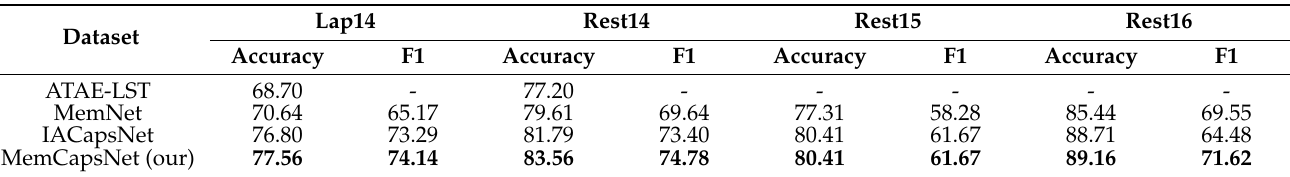
Table 4. The metrics of accuracy and F1-score on four text datasets.